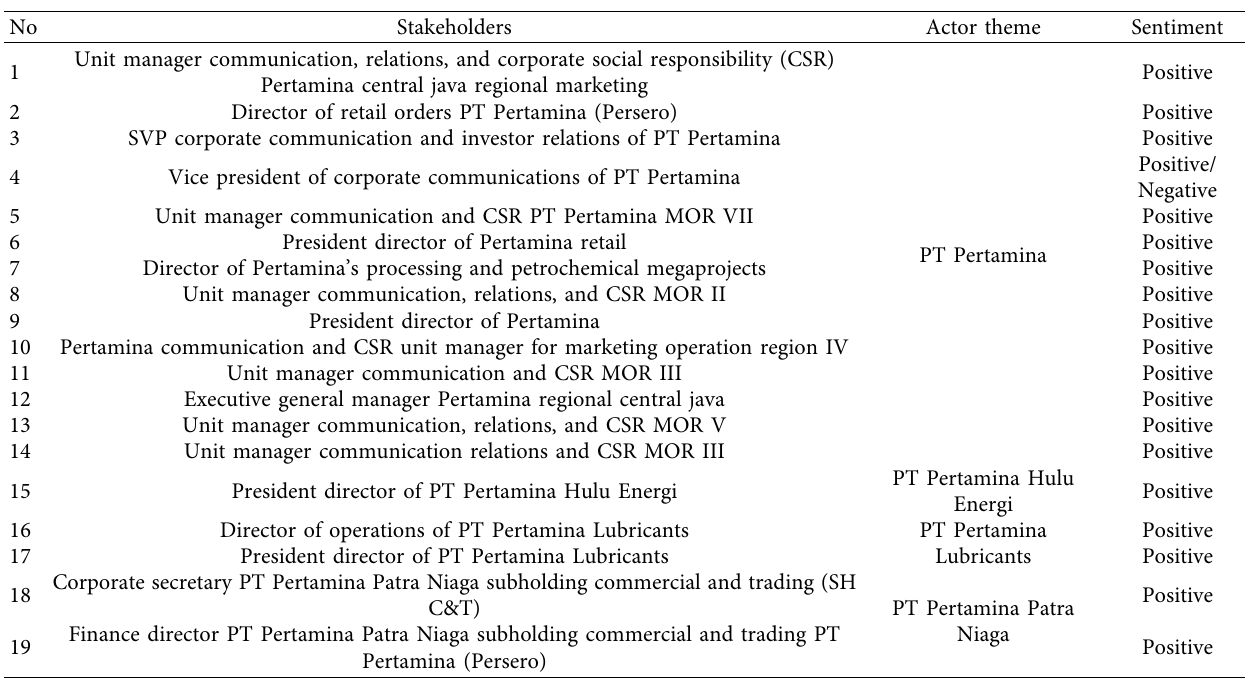
Table 3: Stakeholders and actor